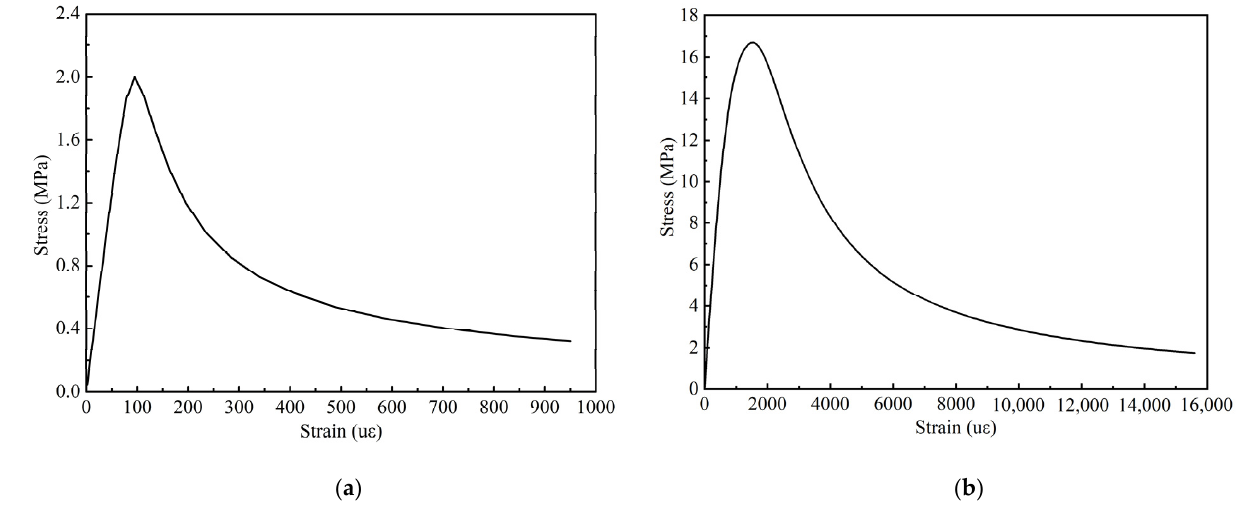
Figure 19. Constitutive relation curves of the concrete. ( a ) The tensile stress–strain curve and ( b ) the compressive stress–strain curve.